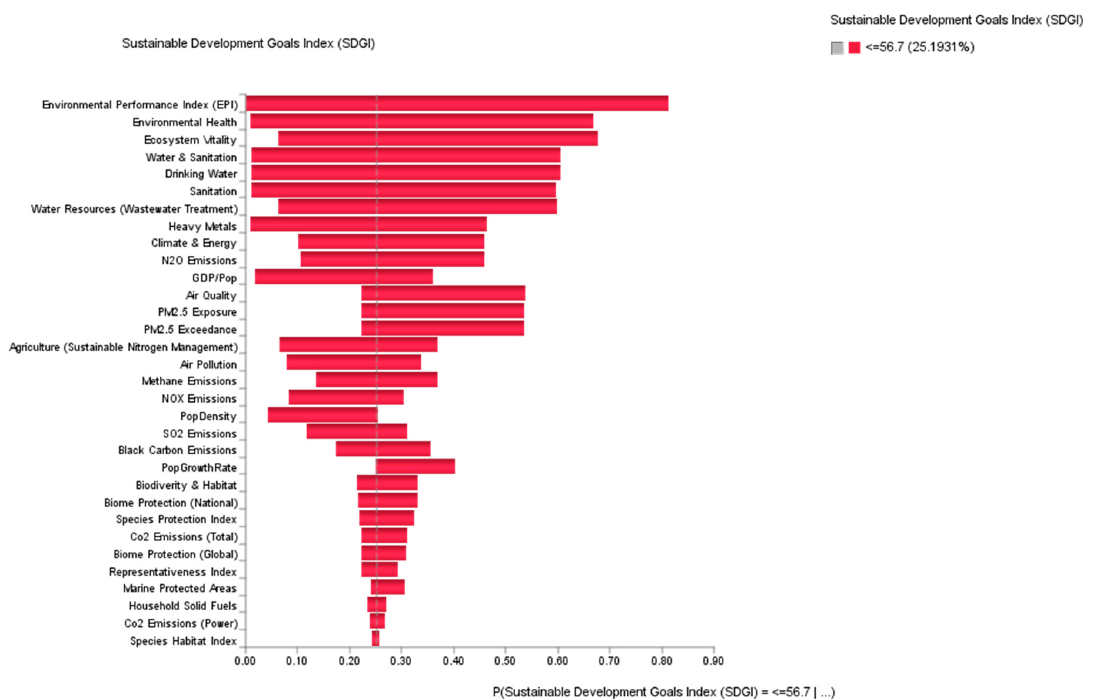
Figure 5. Sensitivity analysis of the sustainability-related variables on the target: low-level SDGI (e.g., 56.7).